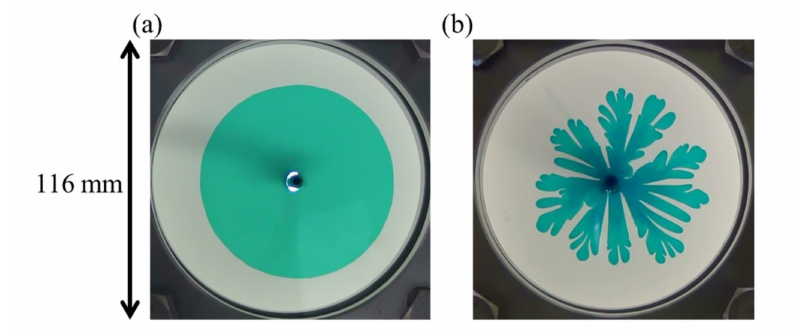
Fluid displacements for ( a ) a hydrodynamically stable condition of the interface, ( b ) a hydrodynamically unstable condition of the interface. The blue solution displaces the surrounding white solution. A more viscous solution is displacing a less viscous one in ( a ) while a less viscous solution is displacing a more viscous one in ( b ). The patterns like fingering in ( b ) are called “Sa ff man–Taylor instability” or “viscous fingering” (VF).